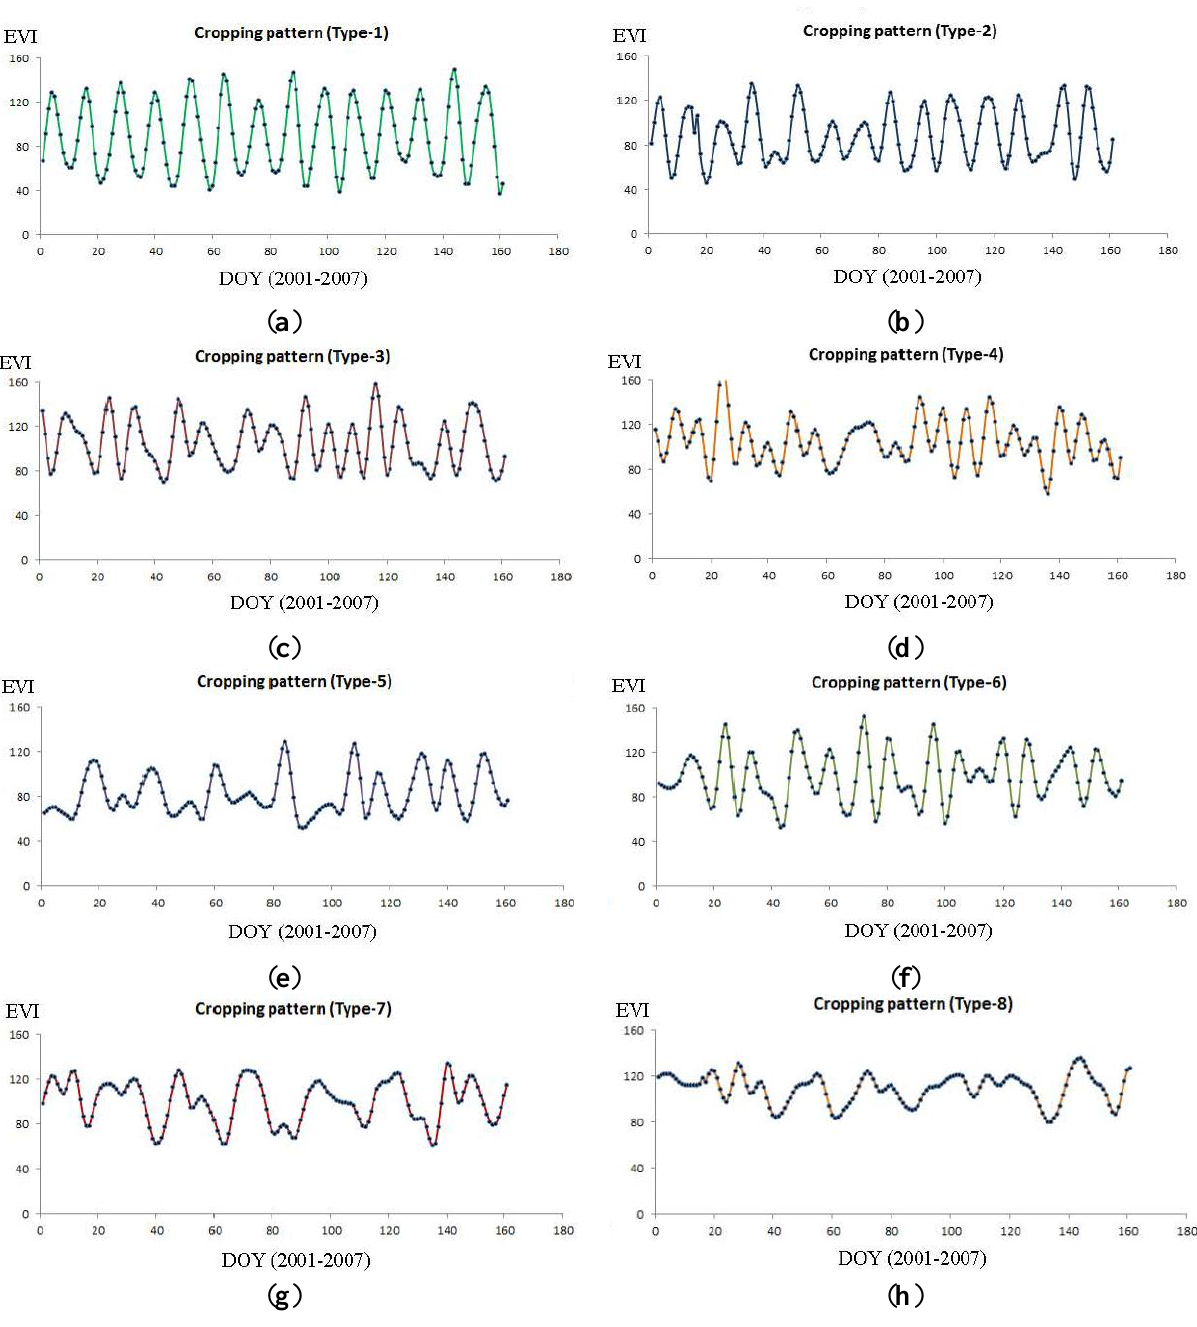
Figure 6. The eight types of annual cropping intensity in Java’s paddy field recognized through the temporal vegetation patterns of EVI (MOD13Q1 product). ( a ) Paddy triple cropping (paddy-paddy-paddy). ( b ) Paddy double cropping (paddy-secondary-crop/bare) in Western Java. ( c ) Paddy double cropping (paddy-secondary-crop/bare) in Central Java. ( d ) Paddy triple cropping (paddy-paddy-secondary crops/bare). ( e ) Paddy double cropping (paddy-paddy-secondary crops/bare) in Eastern Java. ( f ) Paddy double cropping